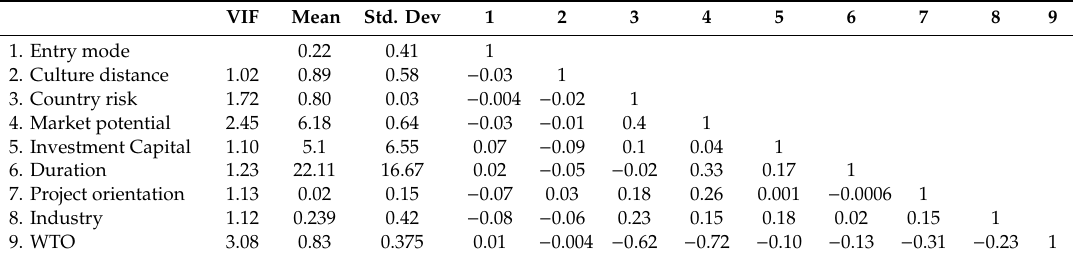
Table 1. Mean, Standard Deviation, and Correlation ( n =